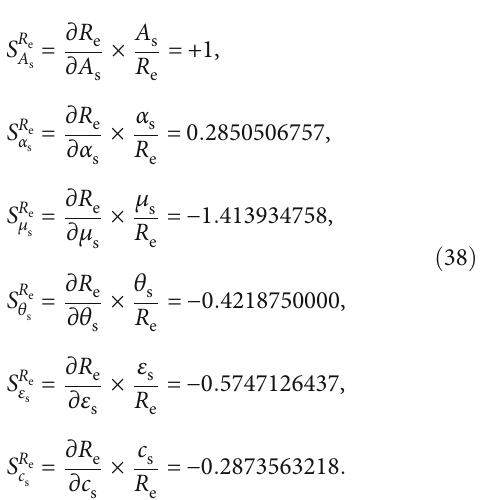
c s ) on the exposed and infected domestic dog